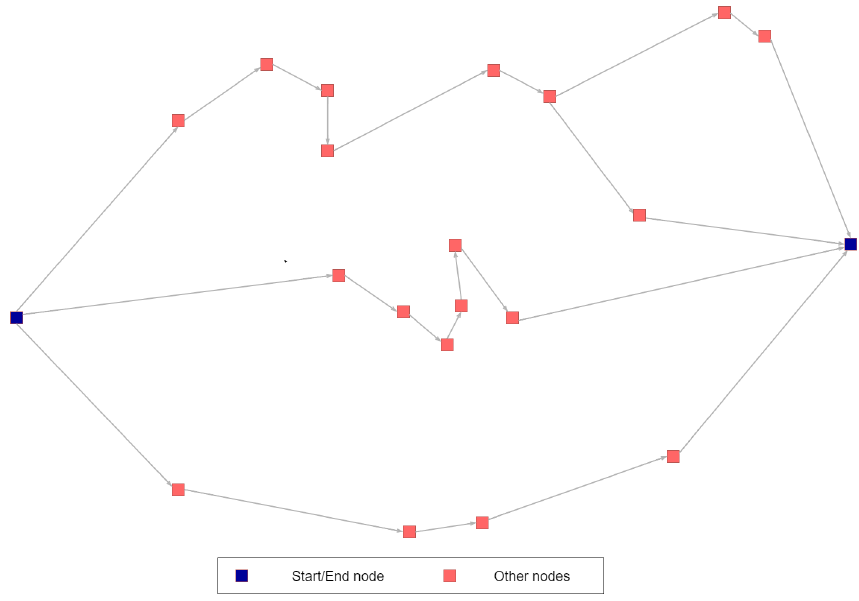
Figure 8. Abstract